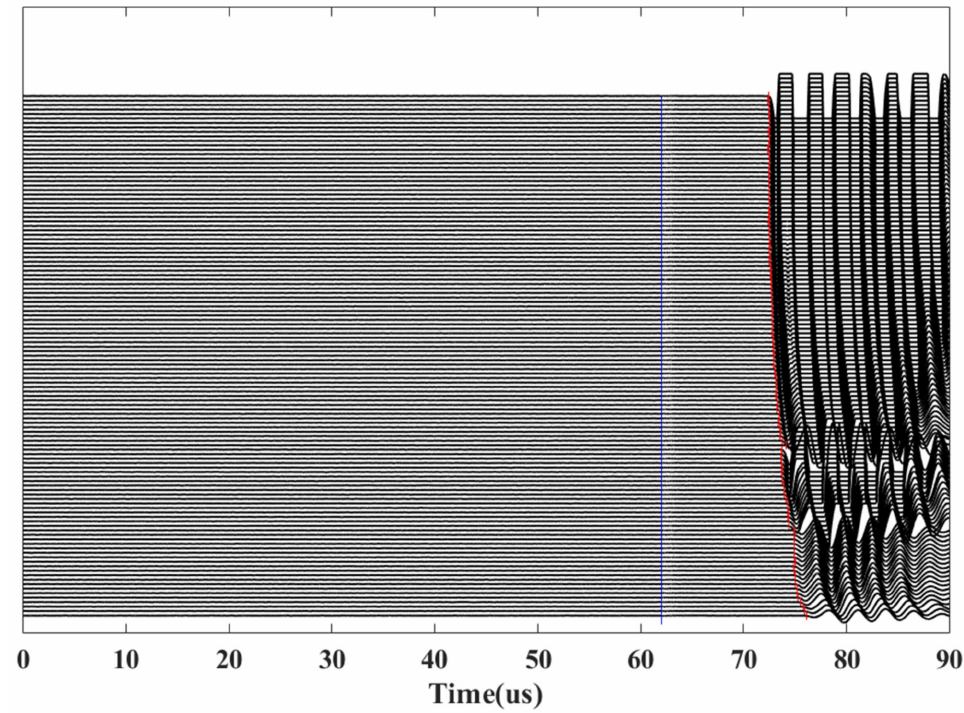
Figure 4. Example of waveforms with respect to PZT6-18 (PZT6 acted as pulse source emission and PZT18 acted as the receiver) during the